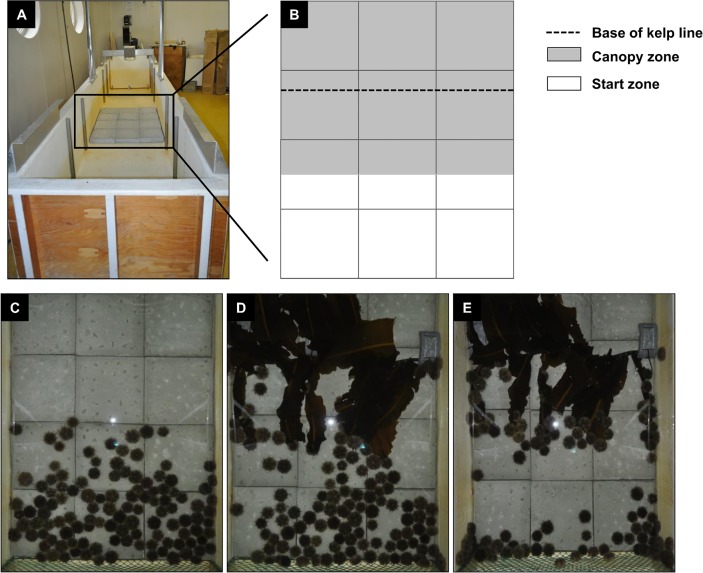
Oscillatory wave tank used in Experiment 2.(A) Position of the experimental area [3×4 grid of concrete tiles of 0.3×0.3×0.05 m each], and (B) relative positions of the kelp (Alaria esculenta) line, zone of maximum canopy cover [Canopy zone], and zone to which green sea urchins (Strongylocentrotus droebachiensis) were introduced prior to the onset of trials [Start zone]. The sequence at the bottom shows urchins at (C) t = 0 [prior to introducing the kelp line], (D) t = 1 h, and (E) t = 6 h [end] of a trial at a wave velocity of 0.1 m s-1 (see Materials and methods for details).